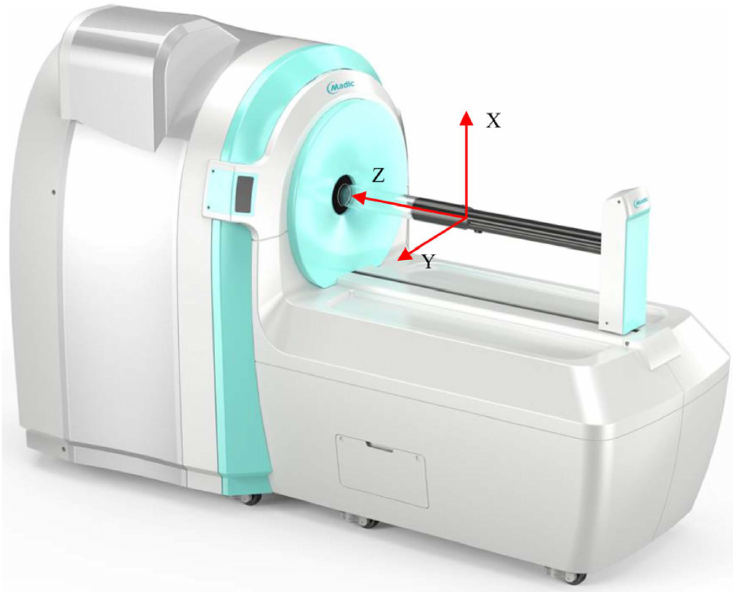
Figure 1. Small-animal Metis™ PET/CT system.